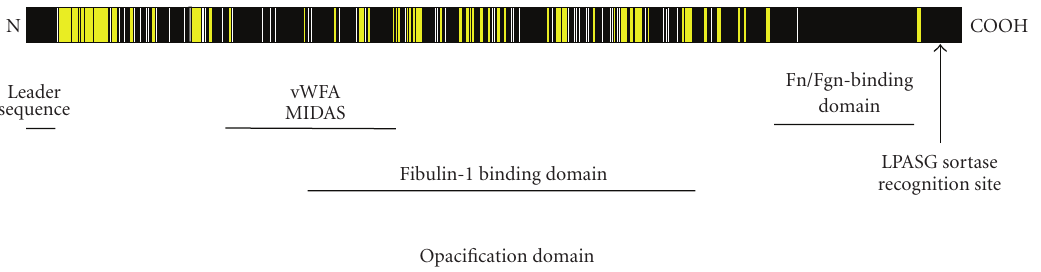
Figure 2: A schematic indicating the location of functional domains within SOF. The yellow segments in the top bar indicate regions of SOF that are highly variable (vary in ≥ 60% of serotypes), black segments indicate highly conserved regions of SOF (conserved in ≥ 60% of serotypes. Only SOFs from S. pyogenes were used to generate this illustration. There are variations in the size of SOF from di ff erent serotypes but most are composed of ∼ 1050 amino acids including the leader sequence. The black lines signify the general location and size of the indicated domains. Abbreviations: vWFA: von Willebrand Factor A domain, MIDAS: metal ion-dependent adhesion site, Fn/Fgn: fibronectin/fibrinogen.